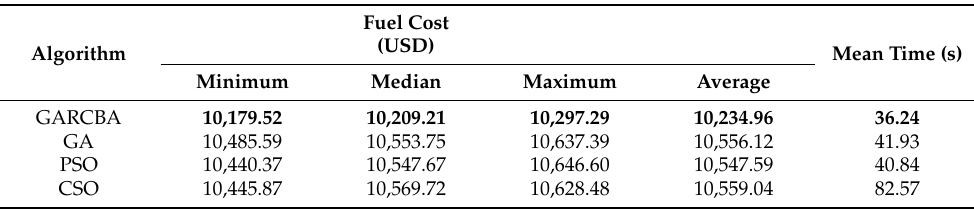
Table 4. Statistical results for Case 1.1 from 25